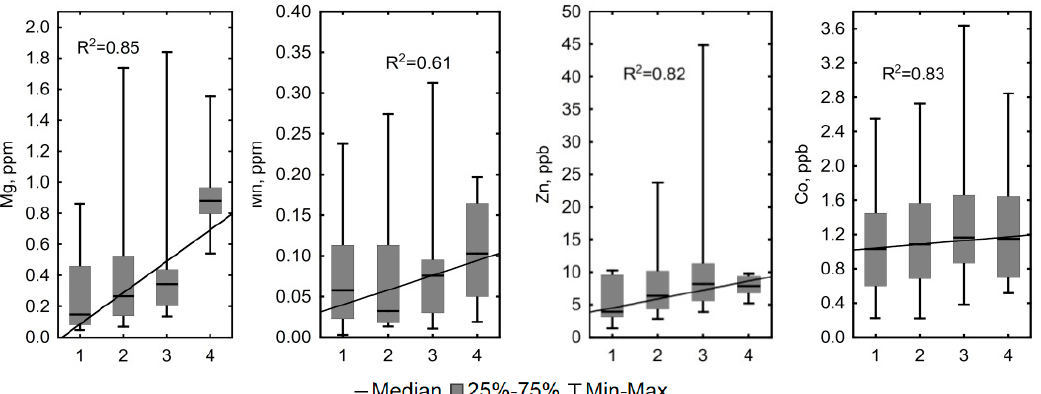
Figure 7. Concentrations of Cl, Li, Na, Mg, Mn, Zn, Co and pH values showed a clear statistically significant trend of increasing concentration (0.56 < R2 < 0.98, p < 0.05) in the bog waters of the KS Tazovsky (Taz) microtopes with different hydrological regimes: 1—polygons occupying elevated dry positions; 2—degraded and flooded polygons and small cracks between polygons; 3—large cracks and fens without a watercourse; 4—lower parts of the fens with watercourse. The solid line is a linear fit for all data with the regression equation given on each graph. It should be noted that the categories (1–4) are becoming increasingly wet from left to right.